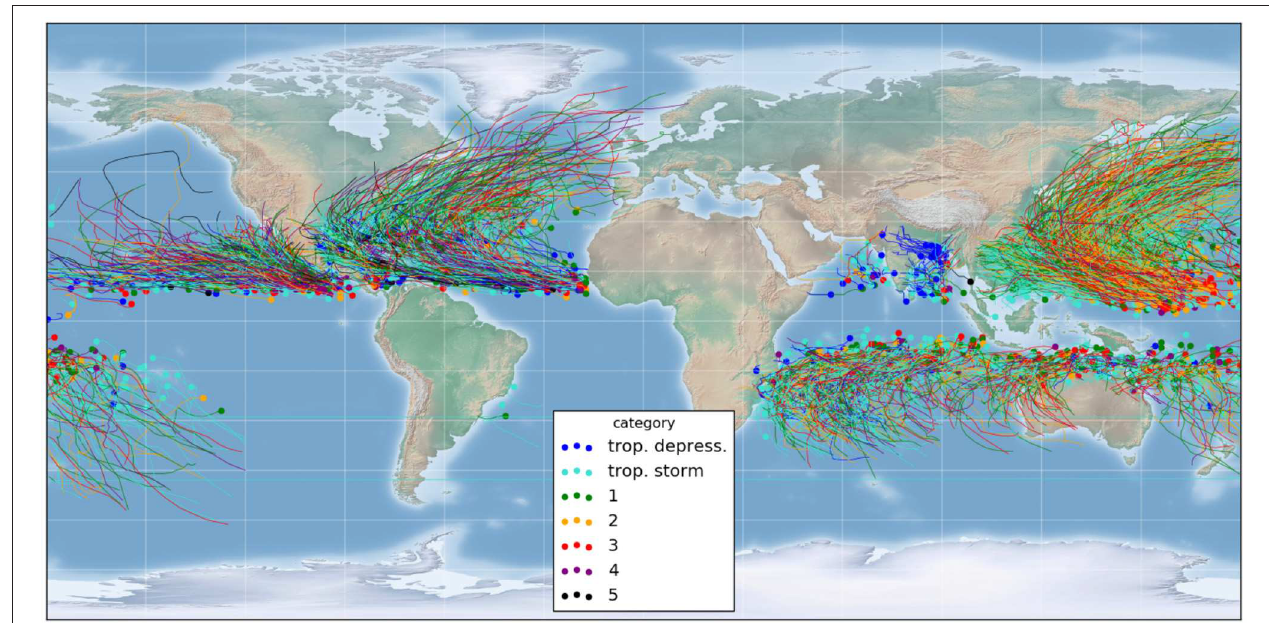
FIGURE 1 | Database: more than 3,000 tropical/extra-tropical storm tracks since 1979. Dots = initial position, colors = maximal storm strength according to the Saffir-Simpson scale.